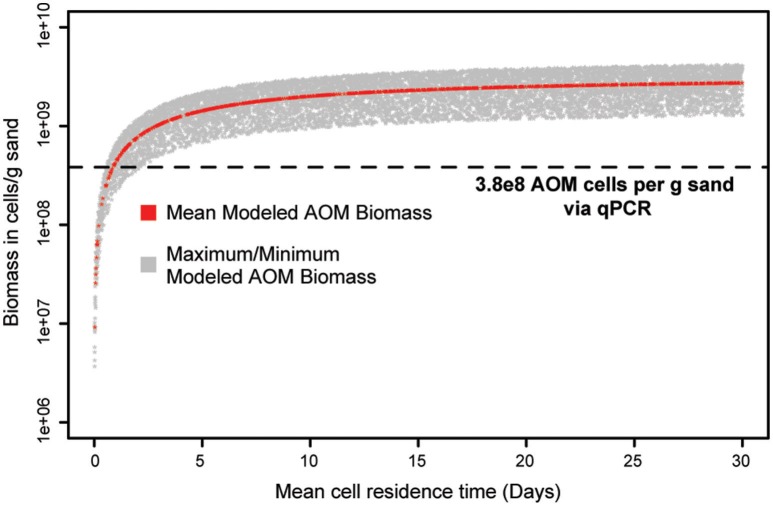
Model output of ammonia-oxidizer cell concentration as a function of biofilter mean cell residence time (MCRT). The red line indicates ammonia-oxidizer cell abundance estimates from the mean change in ammonia concentration across the filter matrix as a function of mean cell residence time. The shaded gray region represents the range of cell abundance estimates from the minimum and maximum observed ammonia removal rates. The horizontal dashed line indicates qPCR estimated total ammonia-oxidizer abundance (ammonia-oxidizing Archaea + ammonia-oxidizing Bacteria + comammox Nitrospira) in the system.